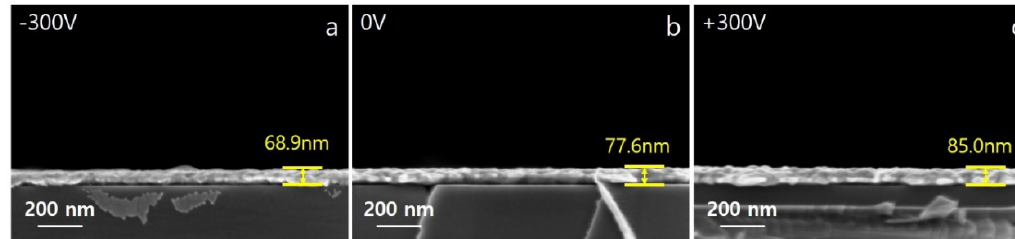
Figure 7. Cross-section FESEM images of the Ag films deposited on Si substrates at the electric biases of ( a ) −300 V ; ( b ) 0 V; and ( c ) +300 V.